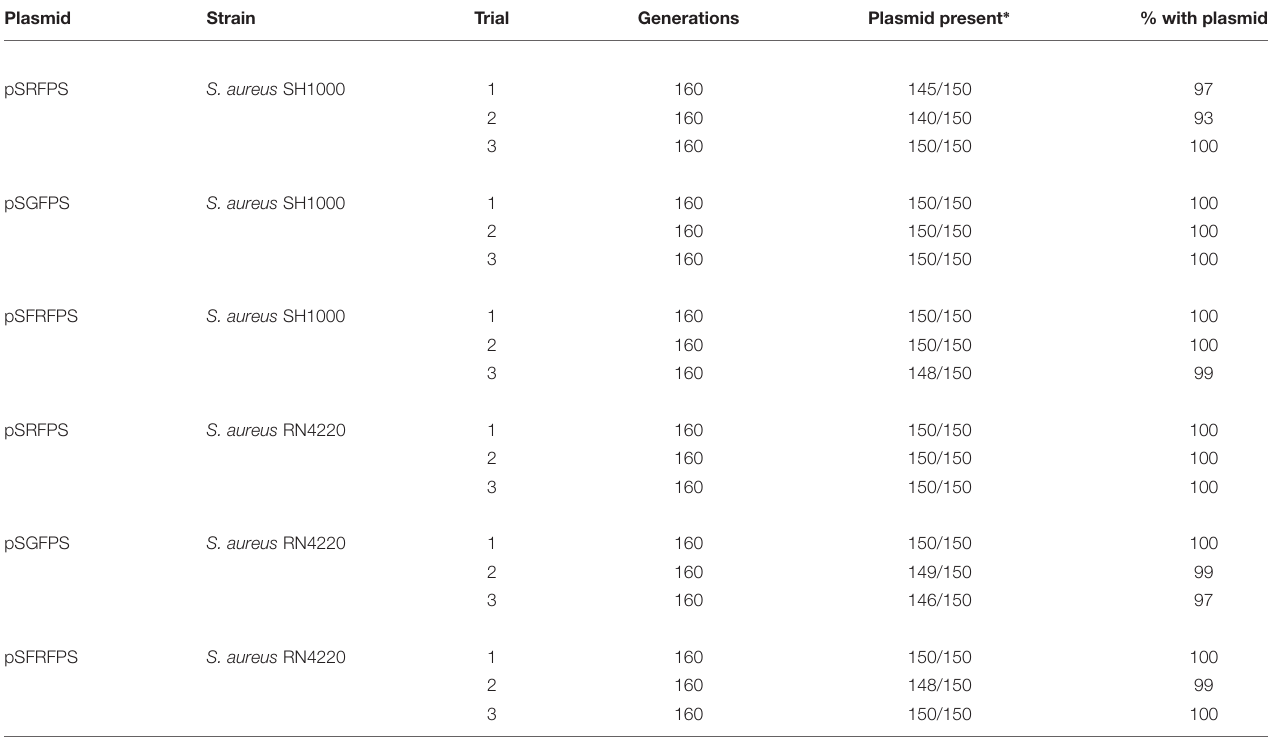
TABLE 3 | In vitro stability of pkk30 reporter plasmids. Plasmid Strain Trial Generations Plasmid present ∗ % with plasmid